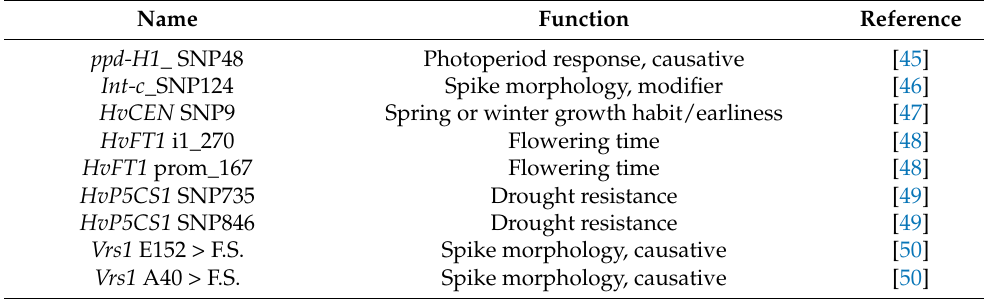
Table 2. SNPs with associated gene functions genotyped in present